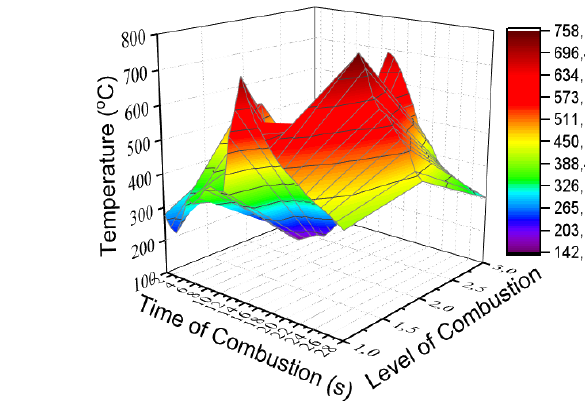
Figure 7. Residual ashes after the burning process.